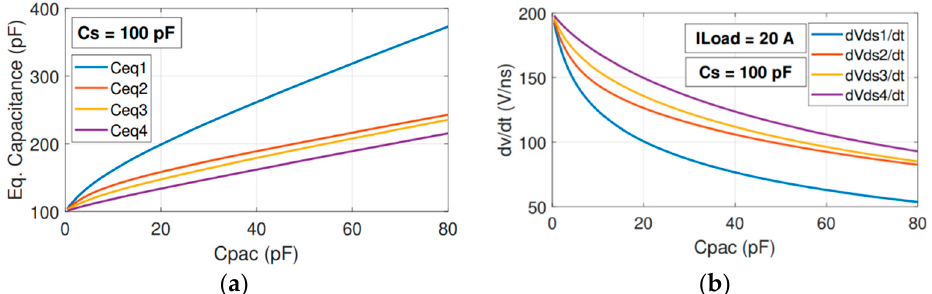
Figure 4. Equivalent parasitic capacitances ( a ) and switching speed behavior ( b ) as a function of C pac .